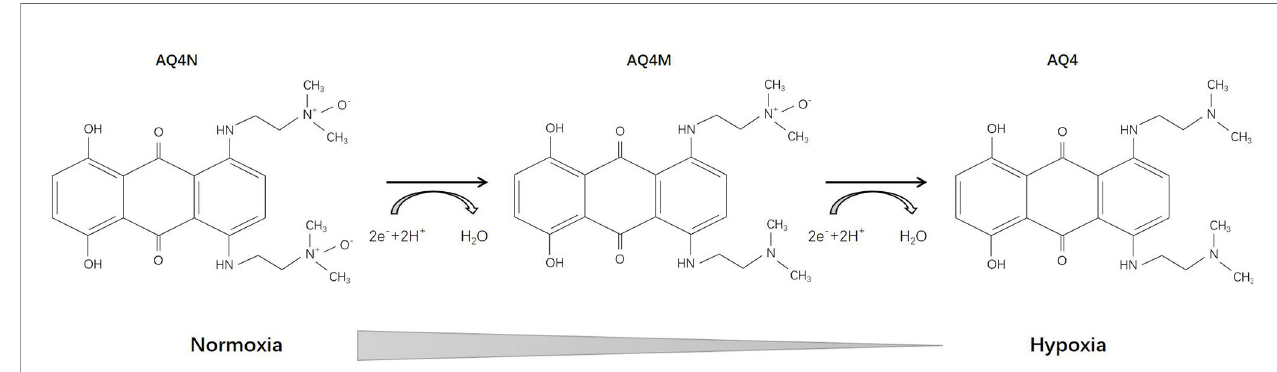
FIGURE 3 | Reductive reaction of